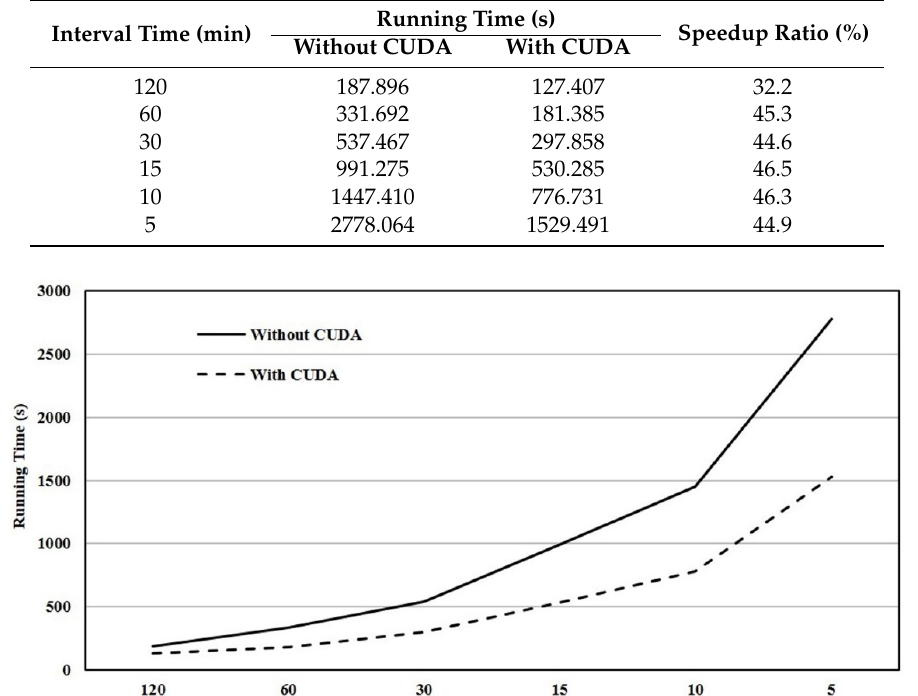
Table 2. Running time with or without Compute Unified Device Architecture (CUDA) and speedup ratio.